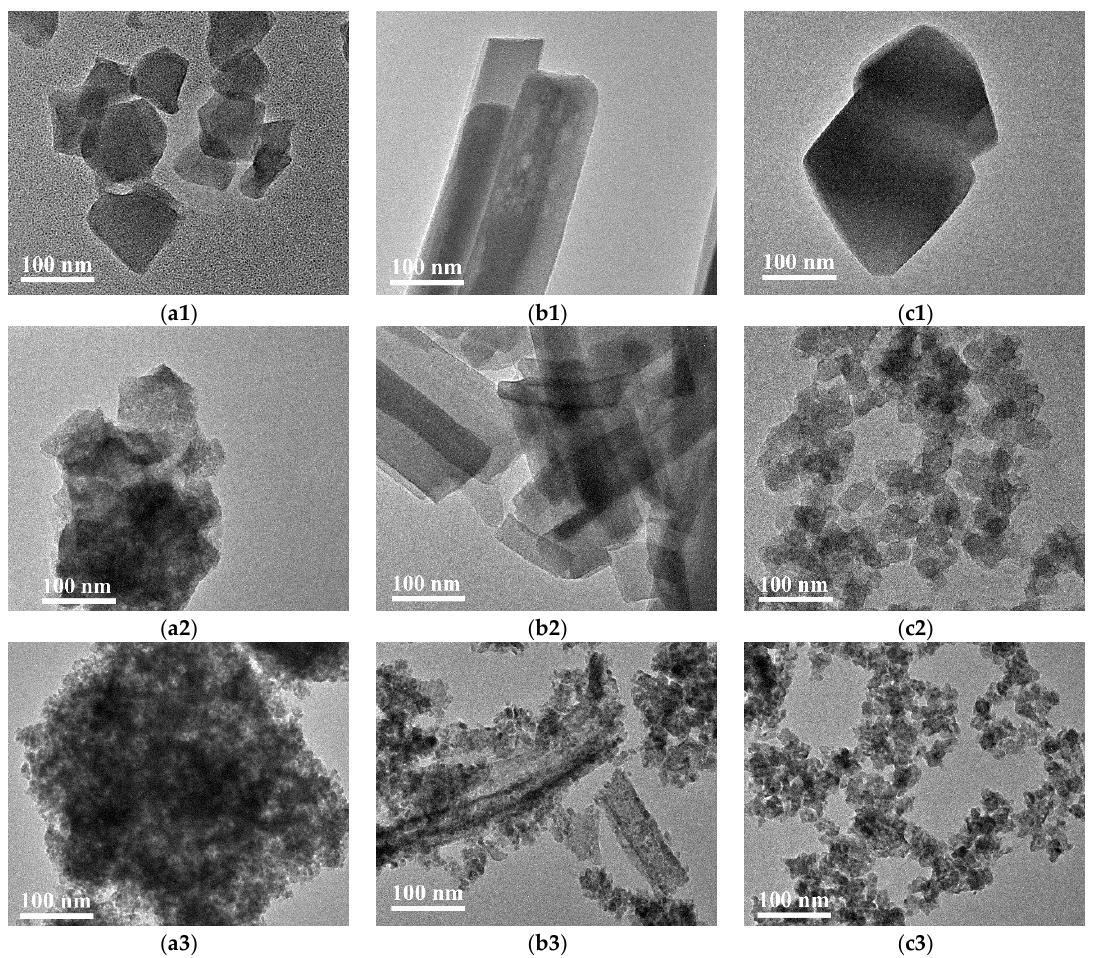
Figure 3. TEM images of Ce-MOF-808, Ce-BTC, and Ce-UiO-66 before calcination ( a1 , b1 , c1 ); Ce-MOF-808-250, Ce-BTC-340, and Ce-UiO-66-320 after calcination at 250 °C, 340 °C, and 320 °C respectively ( a2 , b2 , c2 ); and the corresponding final CeO 2 -MOFs after calcination at 500 °C ( a3 , b3 , c3 ).